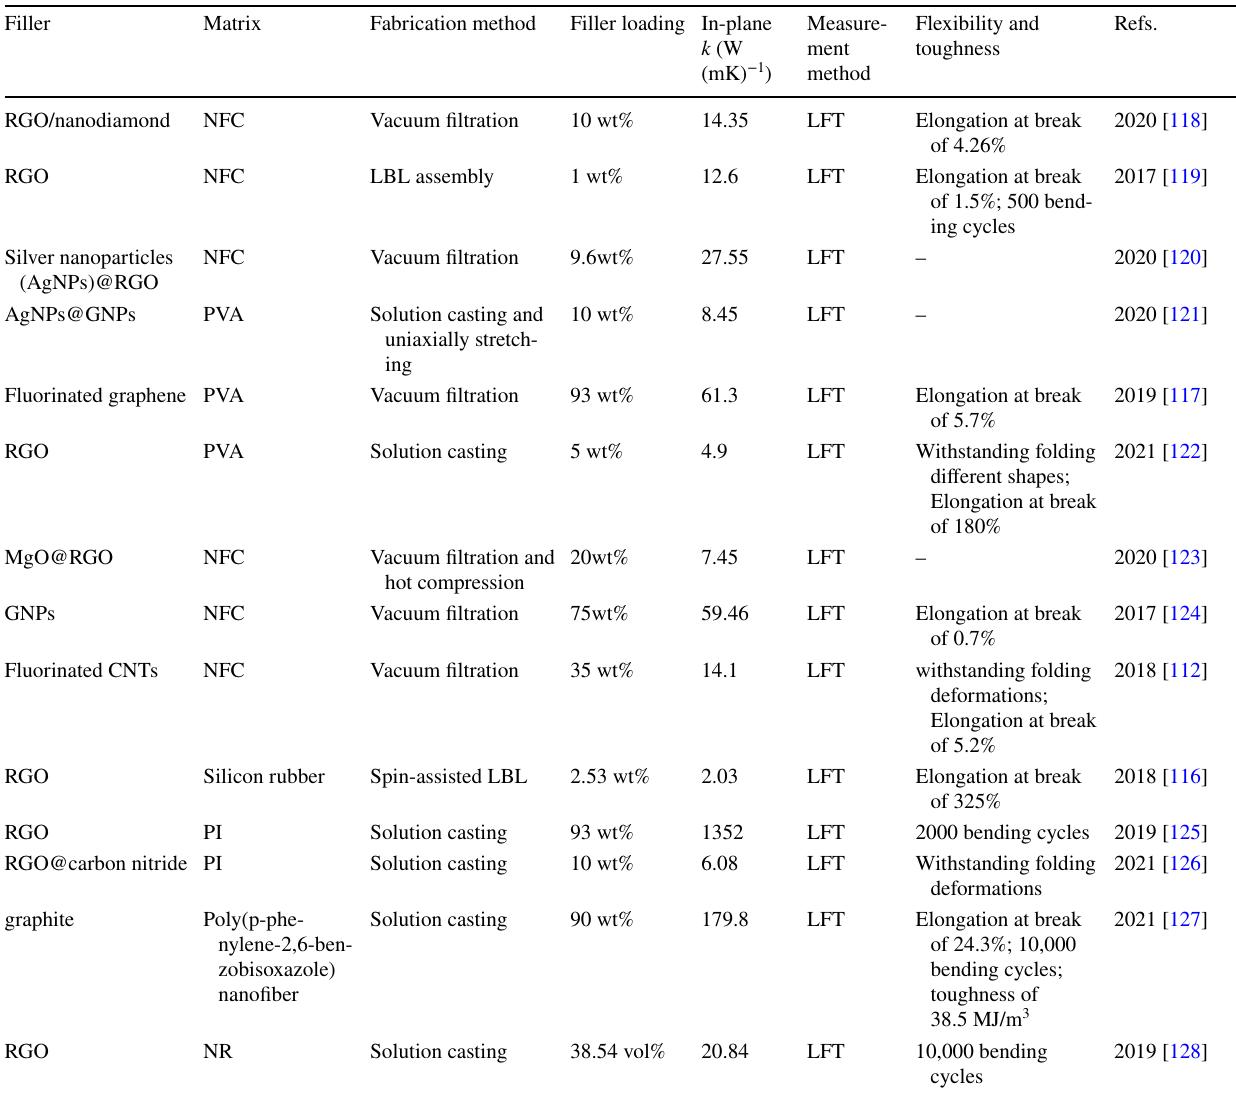
Table 4 The summary of thermally conductive carbon/polymer composite films with high in‑plane k Filler